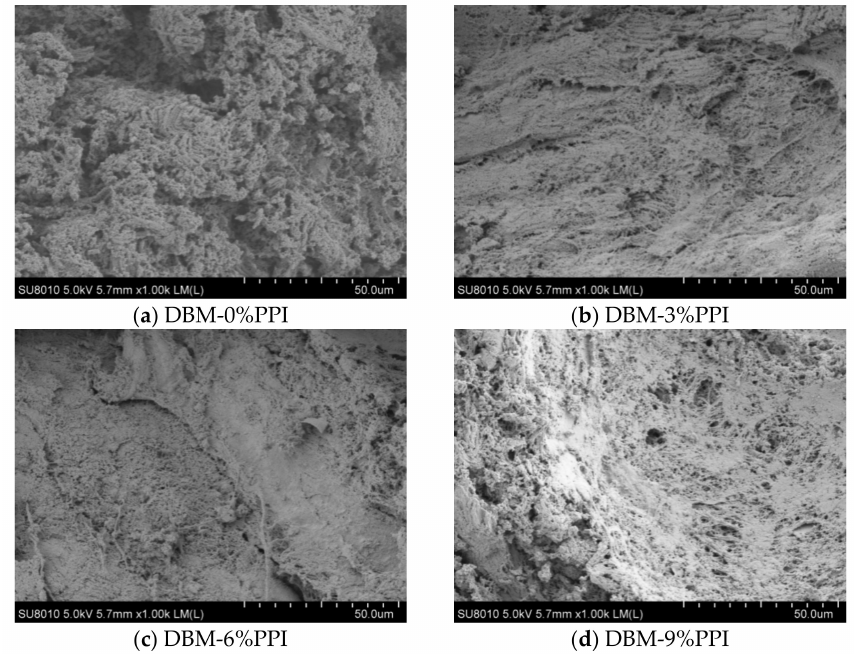
Figure 5. Effect of the pea protein addition level (0%, 3%, 6% and 9%) on the microstructure (Scanning electron microscope, 2000 × ) of DBM-PPI.